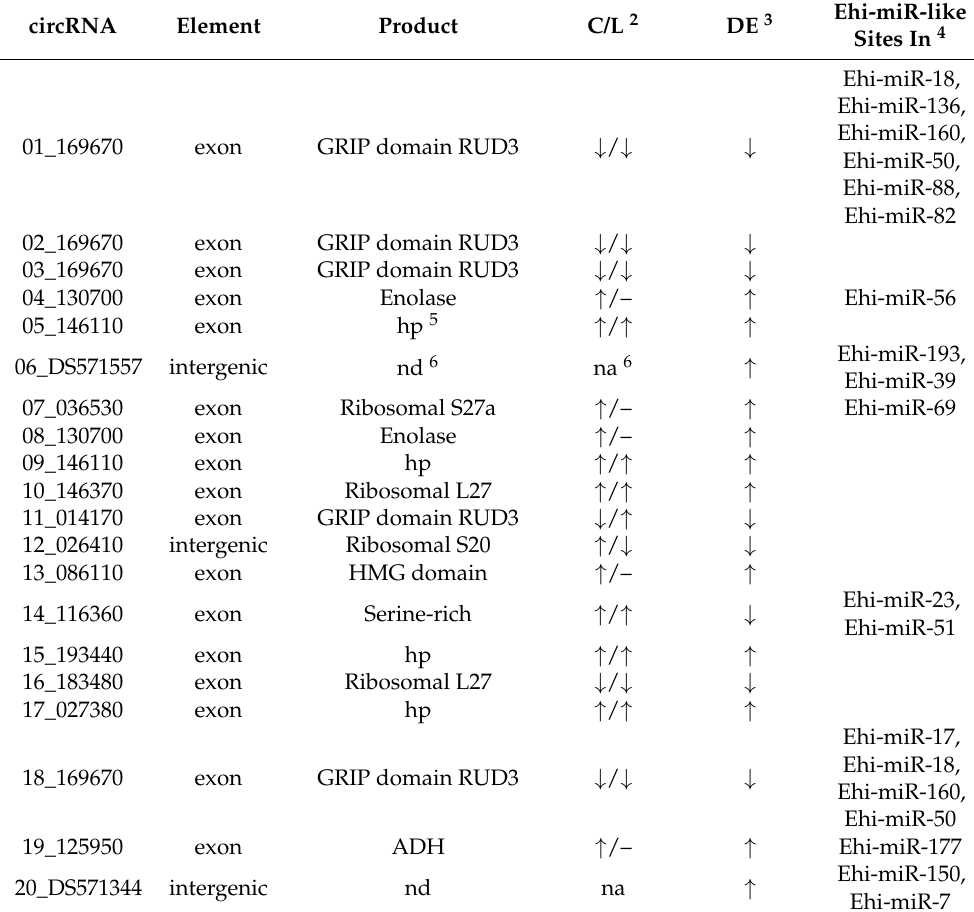
Table 2. Differentially expressed Entamoeba histolytica circRNAs 1 with predicted anti-Ehi-miRNA-like target sites.